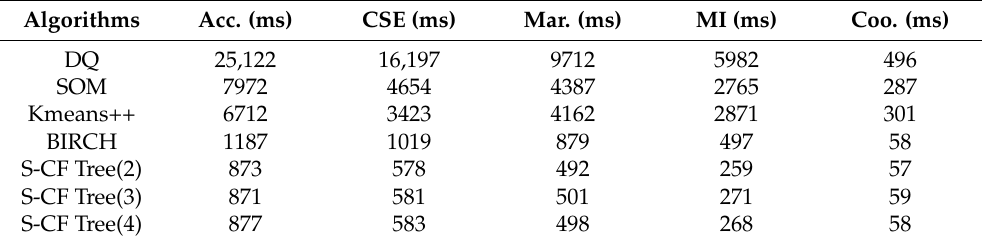
Table 4. Complexity tests (time) with feature selection (FP-Growth).